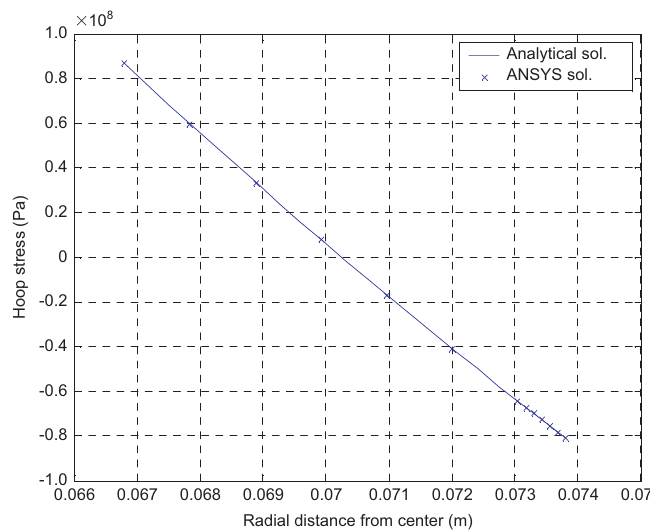
Figure 20 Thermally induced hoop stresses as a function of radial distance from center for an isotropic ring.